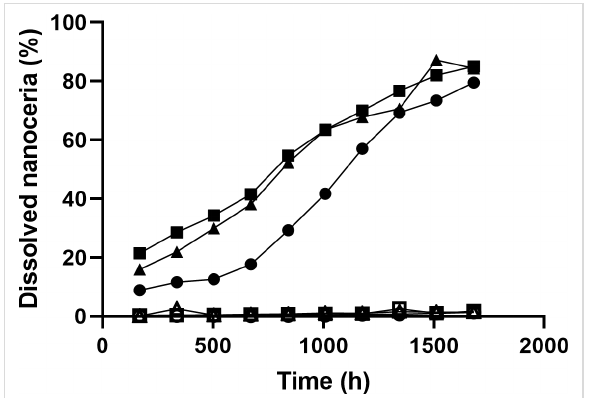
Figure 8: Dissolution of NM-212 and the solvothermally synthesized nanoceria, in the absence and presence of citric and lactic acids, de- termined by the dialysis system. NM-212 in the absence and presence of citric and lactic acids are indicated by open circles, squares, and tri- angles, respectively. Solvothermally synthesized nanoceria in the absence and presence of citric and lactic acids are indicated by solid circles, squares, and triangles, respectively. Results are the mean of two observations.